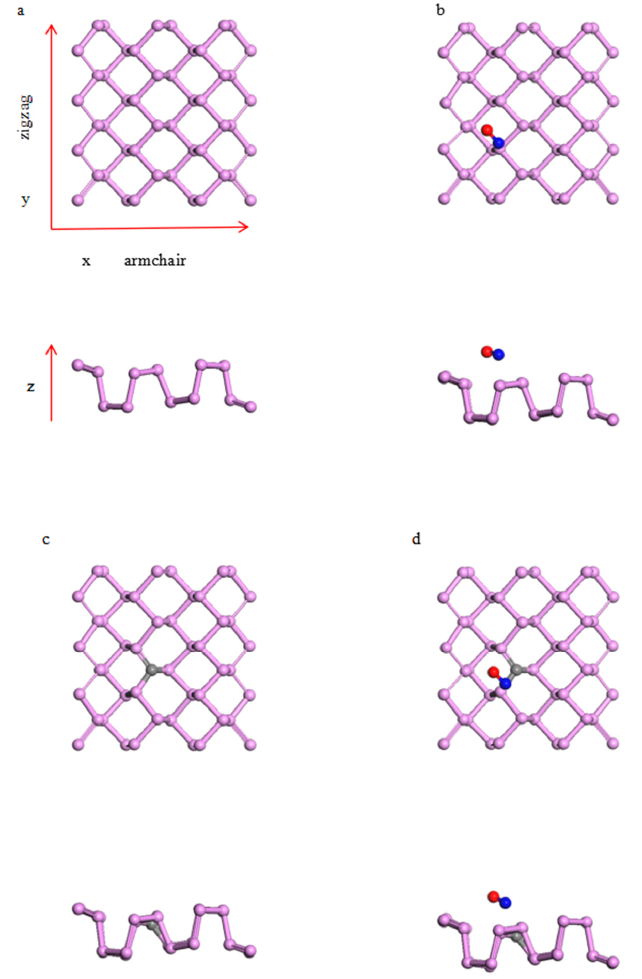
Figure 1. ( a ) Refers to the pristine zigzag phosphorene nanoribbons (ZPNRs); ( b ) refers to the